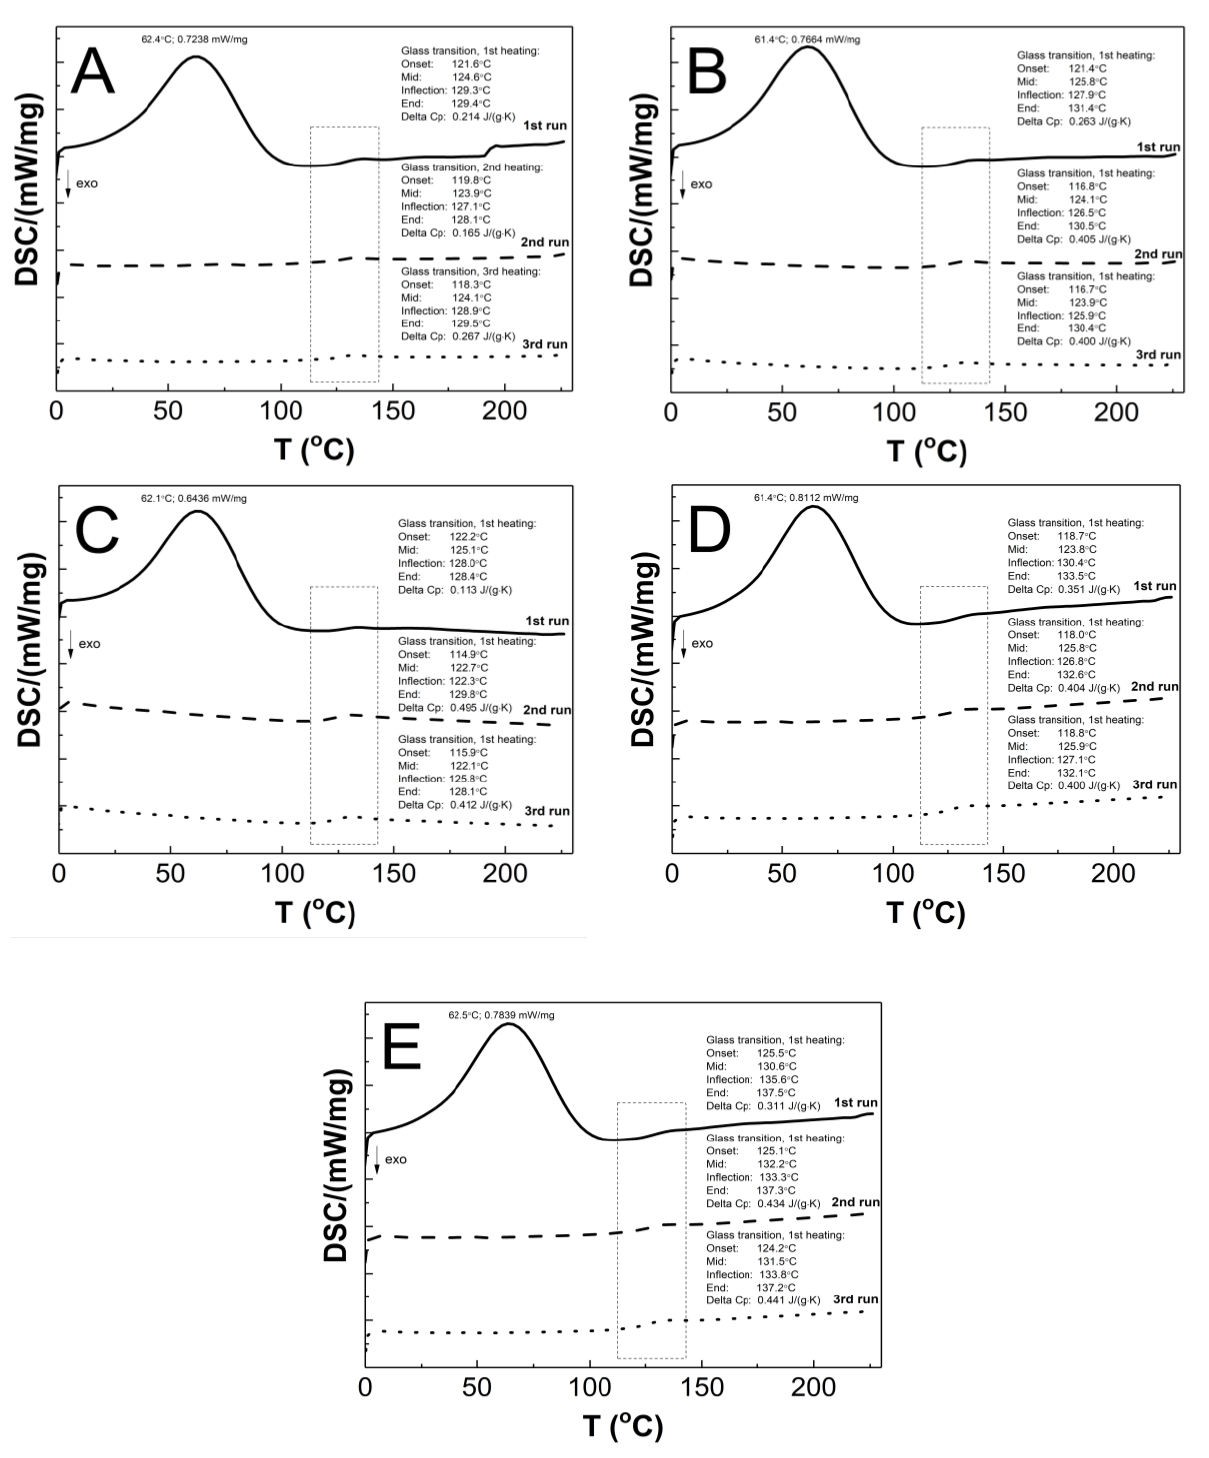
Figure 12. The DSC heating thermograms of 1st (solid line), 2nd (dashed line), and 3rd (dotted line) heating runs for polymers P1 ( A ), P2 ( B ), P3 ( C ), P4 ( D ), and P5 ( E ) at the heating rate β = 5 °C min −1 in a nitrogen atmosphere at 50 mL min −1 .